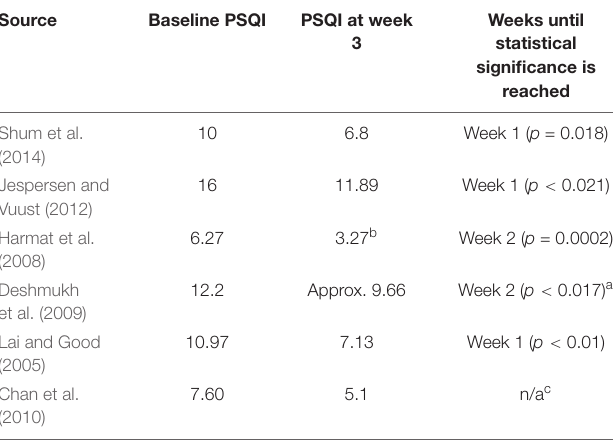
TABLE 2 | Music sleep studies and Influence of Pittsburgh Sleep Quality Index (PSQI) over time on the music sleep studies. Source Baseline